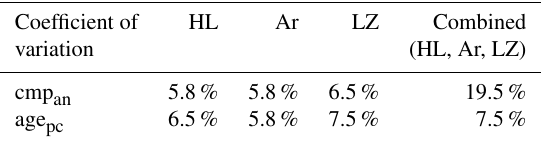
Table 3. Coefficients of variation for the 2000–2017 cumulative compaction anomaly (cmp an ) and firn age at pore close-off depth (age pc ). Values are computed from results of 500 randomly se- lected parameter combinations from the posterior ensembles of each model (HL, Ar, LZ). Coefficients of variation are averaged across all sites of the